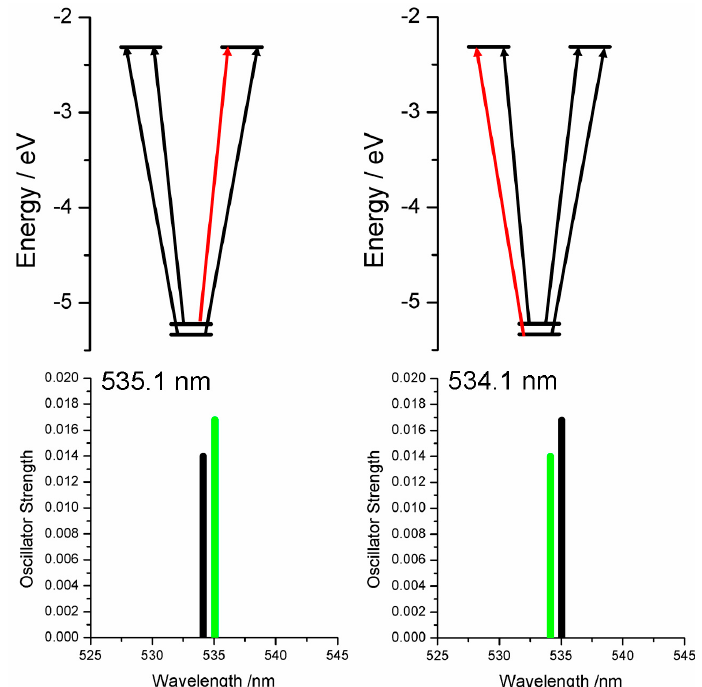
Figure 13. Contributing MOs for the Q-band in Ga(III)-PPIX as obtained from TD-DFT calculations. The Q-band is predicted to be at 535 nm, but is observed at 578 nm. The orbital contributions (black for positive; red for negative) are shown for the green transition at each energy. The black transition is described in the adjacent figures. Two bands are predicted to form the observed Q band, at 535.1 and 534.1 nm. As typically found, the pair of states representing the Q band, result from different combinations of transitions between the same molecular orbitals when the electronic structure of the molecule is not complicated by structural aspects. Reproduced with permission of American Chemical Society [98].